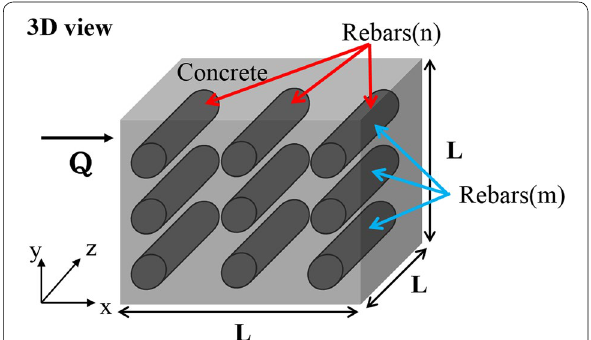
Fig. 2 Schematic of reinforced concrete containing multiple round